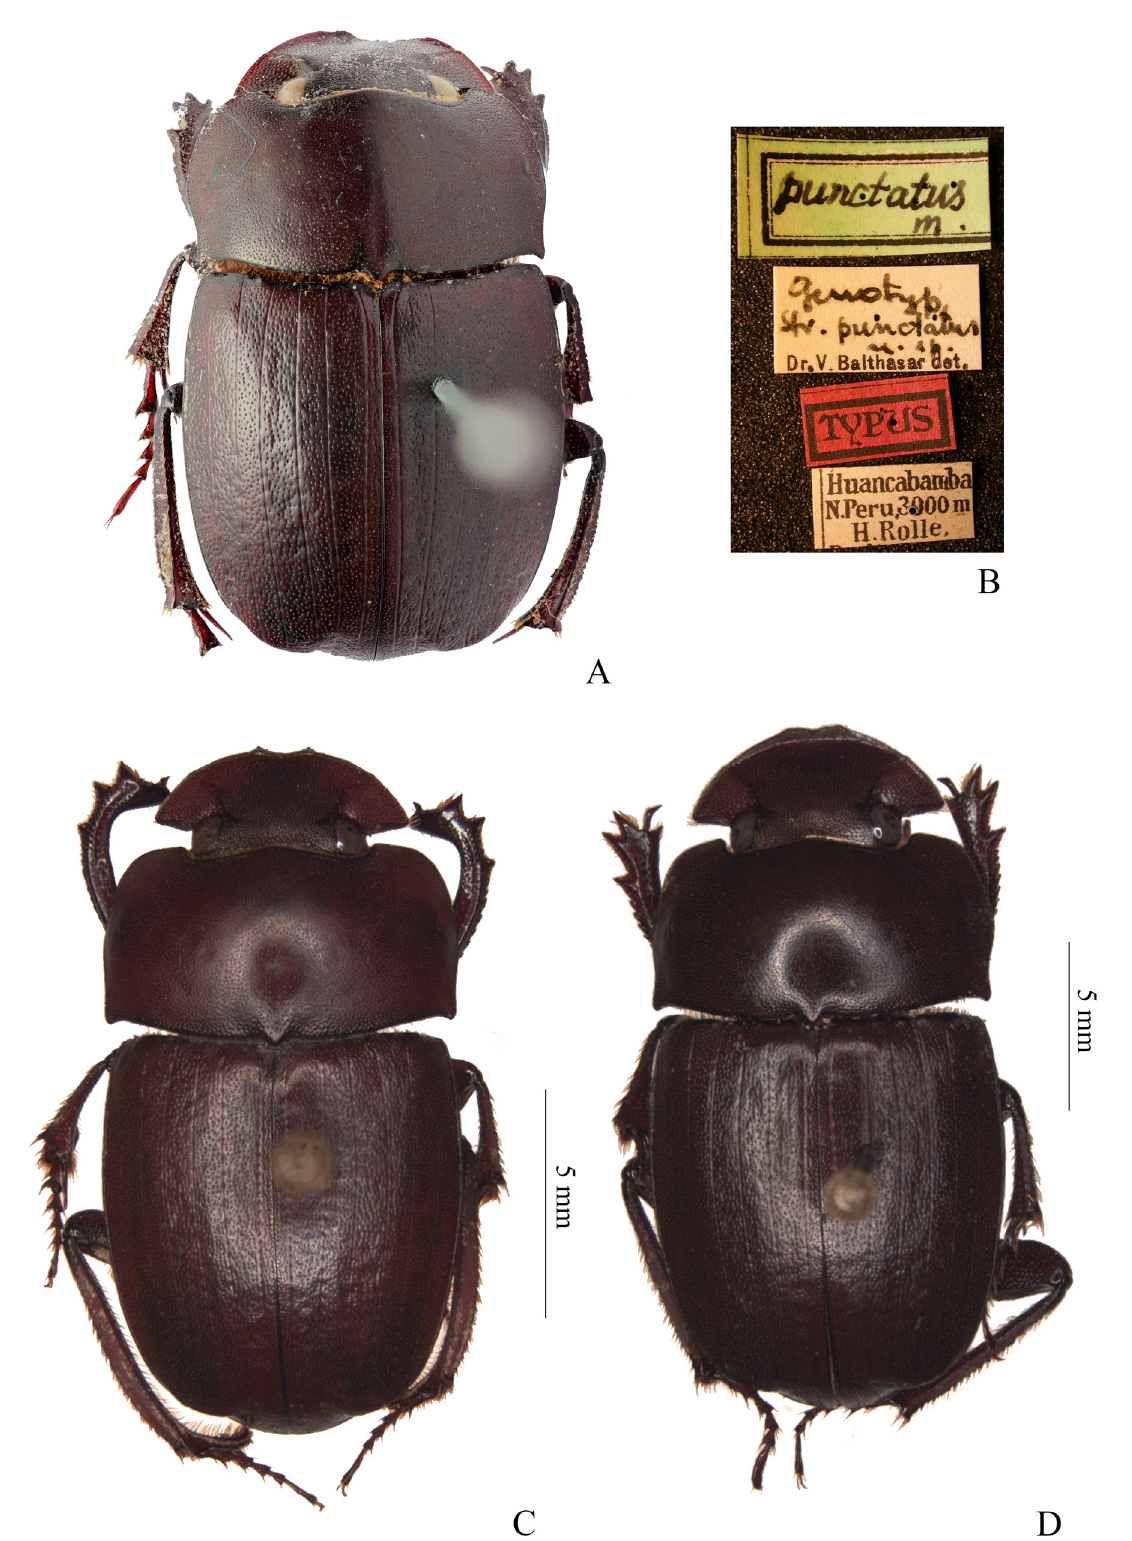
Fig. 3. Streblopus punctatus (Balthasar, 1938). A‒B . Holotype, ♀. A . Dorsal view. B . Attached labels. C‒D . Ordinary specimens, dorsal view. C . ♂. D .